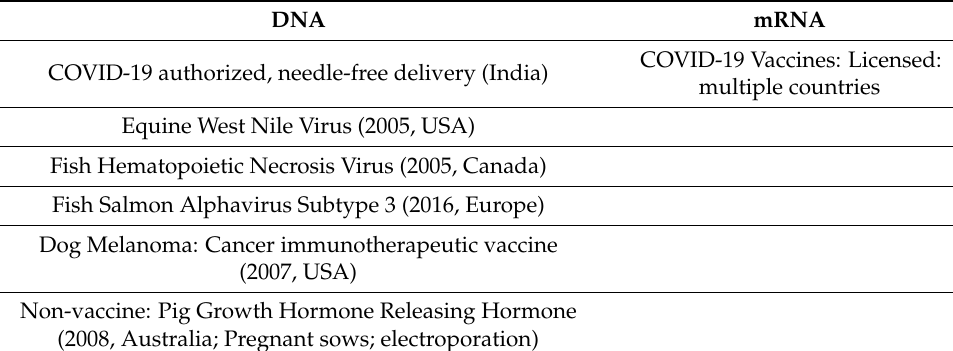
Table 4. DNA and mRNA Authorizations/Licensures: Prophylactic and Therapeutic. DNA mRNA COVID-19 authorized, needle-free delivery